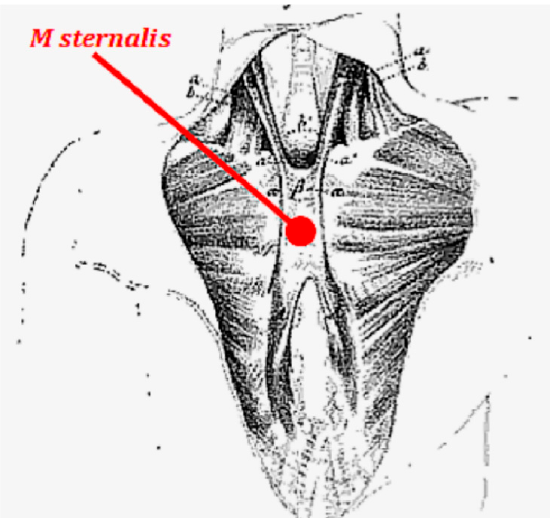
Figure 1. A bilateral M sternalis; the contralateral clavicular attachment is characteristic of Type II-1 in Jelev et al. [8]. Source: figure 3 in Gruber [19]. Public domain based on publication date.